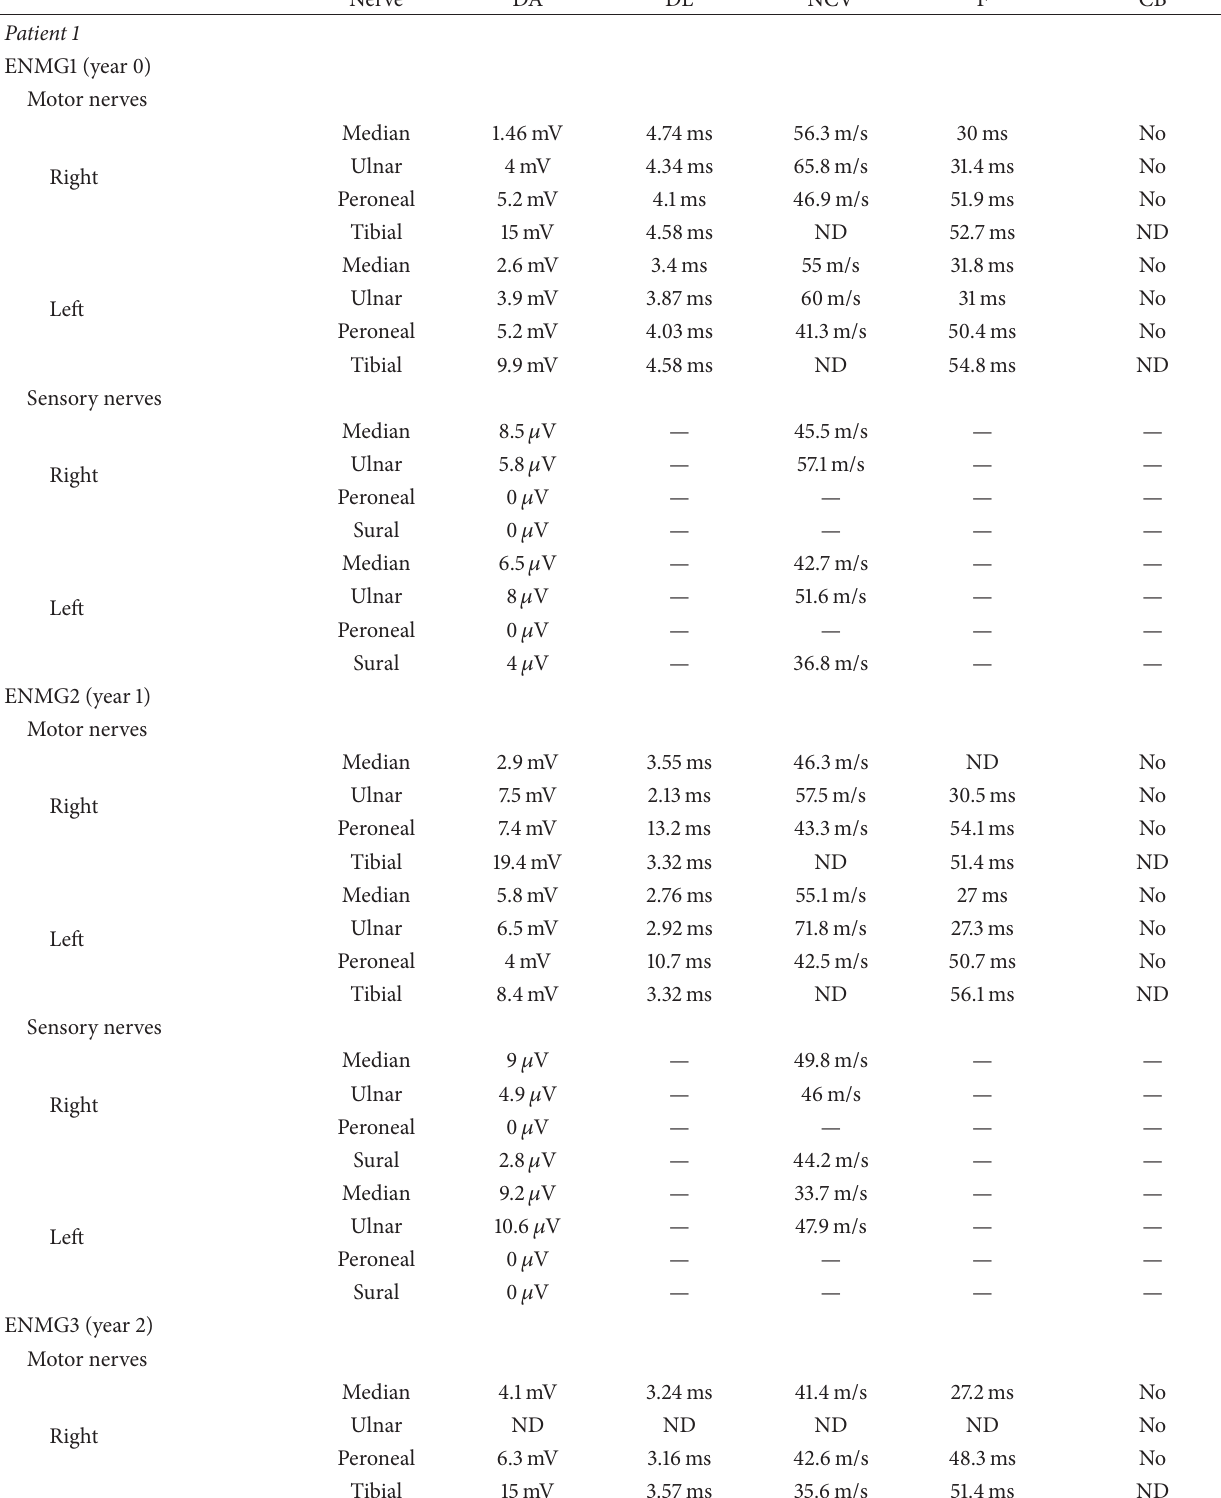
Table 1: Motor and sensory nerve conduction studies: follow-up of our two patients. Nerve DA DL NCV F CB